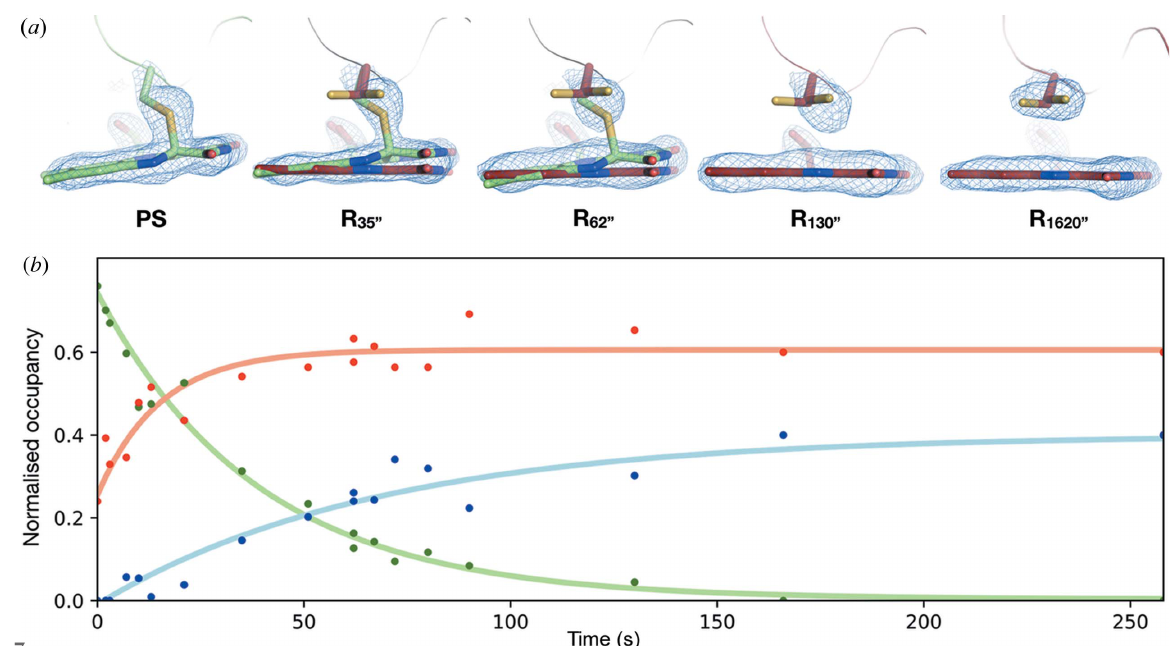
Figure 7 Relaxation of the photoadduct in LOV2 monitored by time-resolved crystallography. ( a ) Evolution of the 2 F obs – F calc electron density map contoured at a 1.5 (cid:4) level superimposed on the C426 and the FMN chromophore at selected time points between the PS equilibrium ( t < 0 s) and 1620 s (L-state in green, D 00 -state in firebrick). ( b ) Occupancy evolution over time of the three conformations of C426 showing the progressive disappearance of the photoadduct (conformation C: green) and the appearance of the two ground state conformations (major conformation A: orange, minor conformation B: